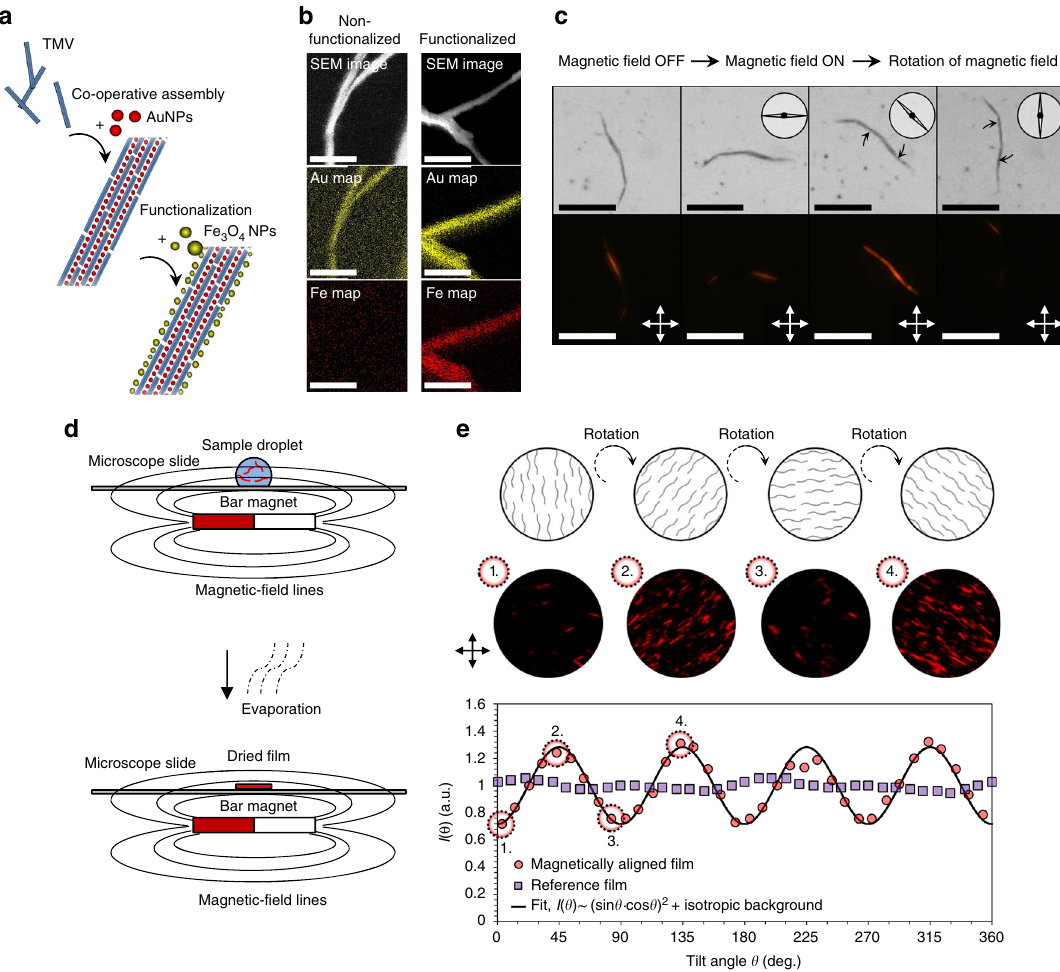
Fig. 5 Magnetic alignment of functionalized superlattice wires yields a plasmonic polarizer. a Scheme of the preparation of magnetic superlattice wires. b SEM images and EDX maps of non-functionalized and functionalized superlattice wires. Functionalized superlattice wires show a smooth coverage of iron implying that Fe 3 O 4 nanoparticles bind ef fi ciently to the wires. c Optical ( above ) and polarized light ( below ) microscope images of a functionalized waterborne superlattice wire, which is rotated by a magnetic fi eld. The direction of the magnetic fi eld is indicated by the schematic compass needle. Segments of the superlattice wire that are oriented in the directions of the crossed polarizers are not visible. d An oriented fi lm was prepared by drying a suspension of Fe 3 O 4 nanoparticle functionalized superlattice wires in a magnetic fi eld (5 ± 1 mT). e The linear polarization of the fi lm was demonstrated by polarized light microscopy. The transmitted intensity I ( θ ) can be modulated by rotating the fi lm in an angle θ with respect to the crossed polarizers as structures oriented in the directions of the crossed polarizers are not visible. Four examples of images (the diameter of the circular area is 0.3 mm) that were used to obtain I ( θ ) data points are shown. The reference fi lm was formed without an applied magnetic fi eld. The direction of the crossed polarizers are indicated by double arrows c , e . Scale bars : 2.5 µ m b and 50 µ m